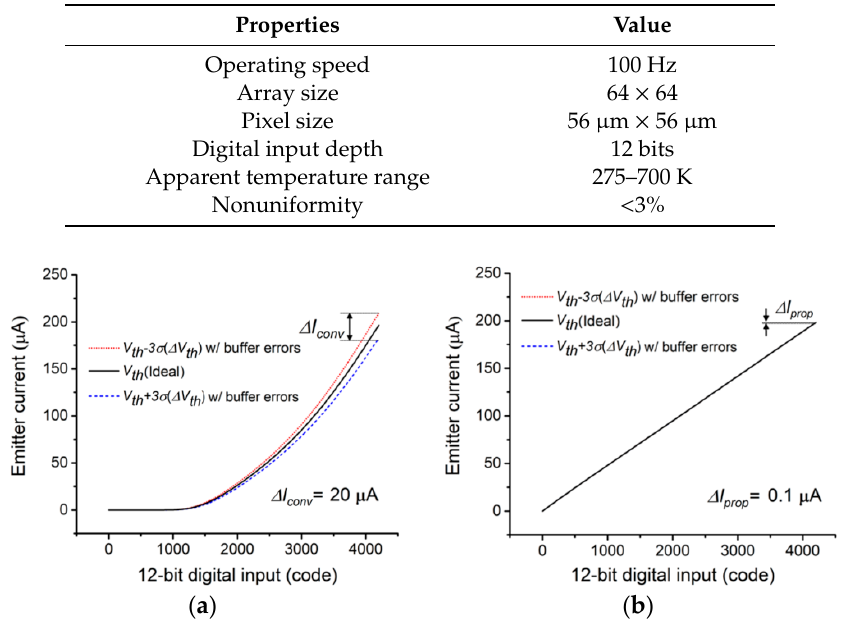
Figure 7. Emitter current of the IR emitter: ( a ) conventional RIIC; ( b ) proposed RIIC.